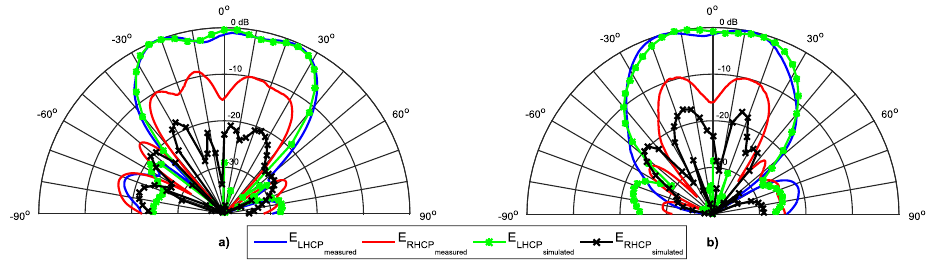
Figure 13. Normalized radiation pattern at 5.8 GHz. ( a ) Plane φ = 0°; ( b ) Plane φ = 90°.